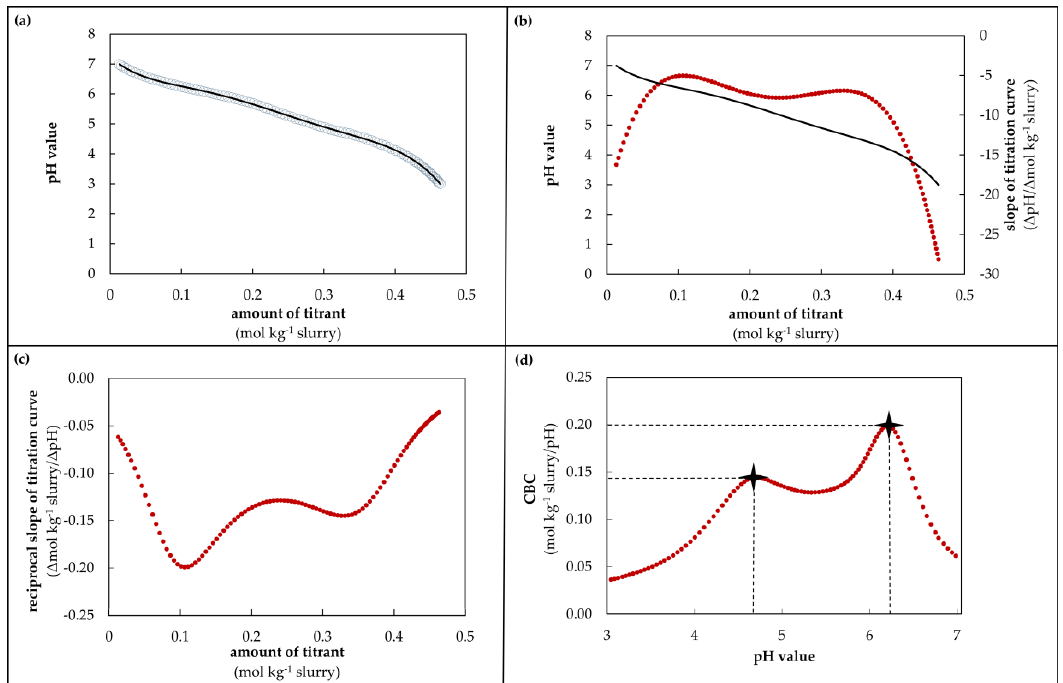
Figure 2. Procedure of the determination model for bu ff er capacity; ( a ) pH value in dependency of the amount of titrant and polynomial regression line; ( b ) polynomial regression line and derived titration curve which stands for the slope of titration curve; ( c ) reciprocal derived titration curve in dependency of amount of titrant; ( d ) current bu ff er capacity in dependency of pH value.